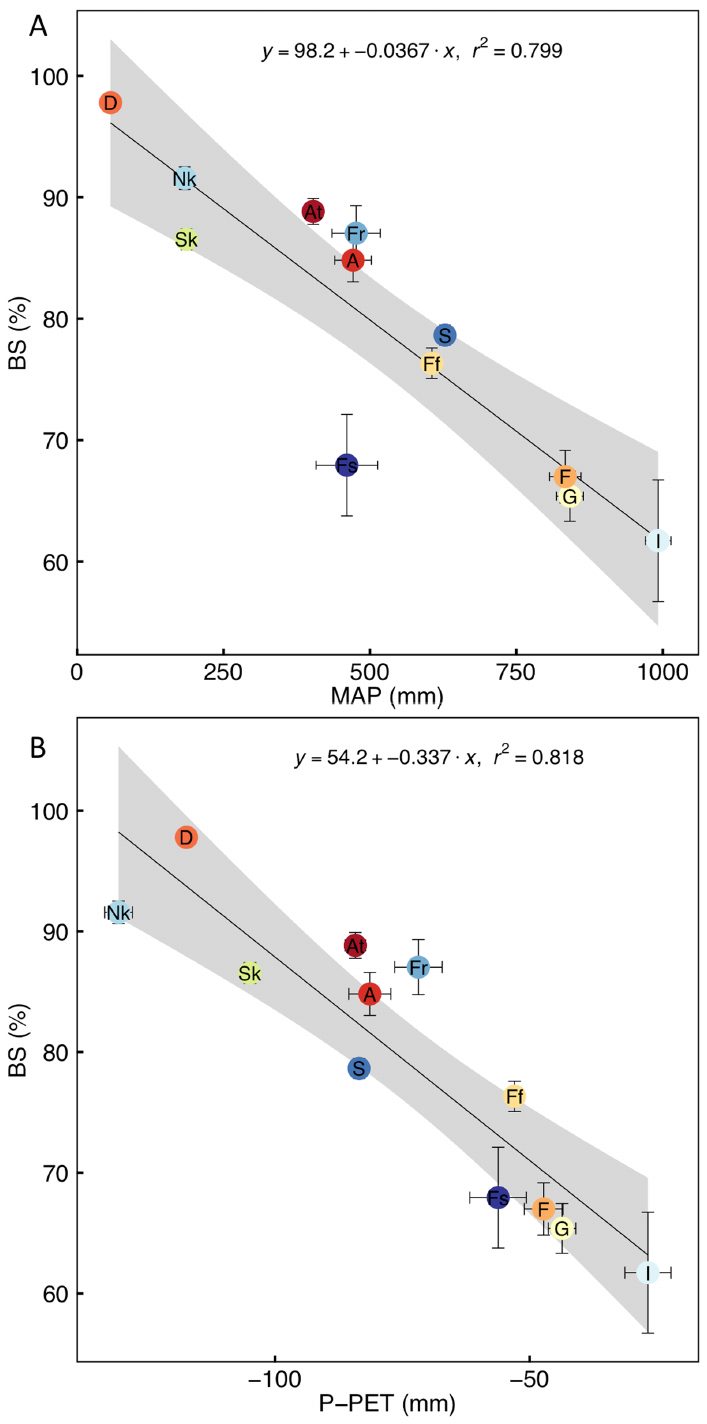
Fig 5. Correlation between base saturation (BS) and (A) the average annual precipitation (MAP) and (B) water availability measured as the average of monthly precipitation — potential evapotranspiration (PET) of each vegetation type (Fynbos separated into strandveld, renosterveld and fynbos). The vegetation types are indicated by codes (see Table 1). The coefficient of determination (r 2 ) is shown for significant relationships (P < 0.05). Points and error bars indicate mean ± SE (for n see Table 1) and the grey bands indicate the 95% confidence